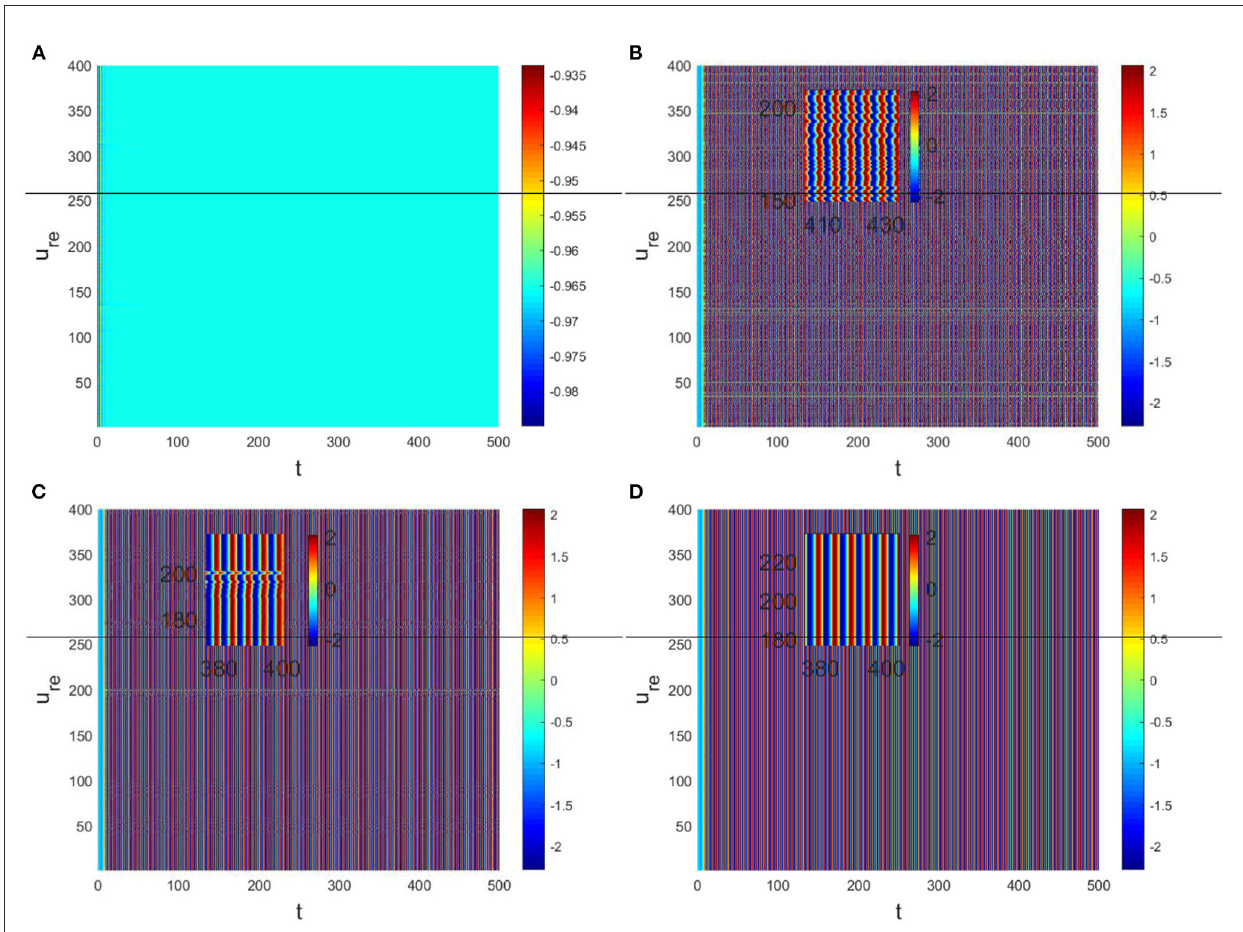
FIGURE9 Pattern with D u